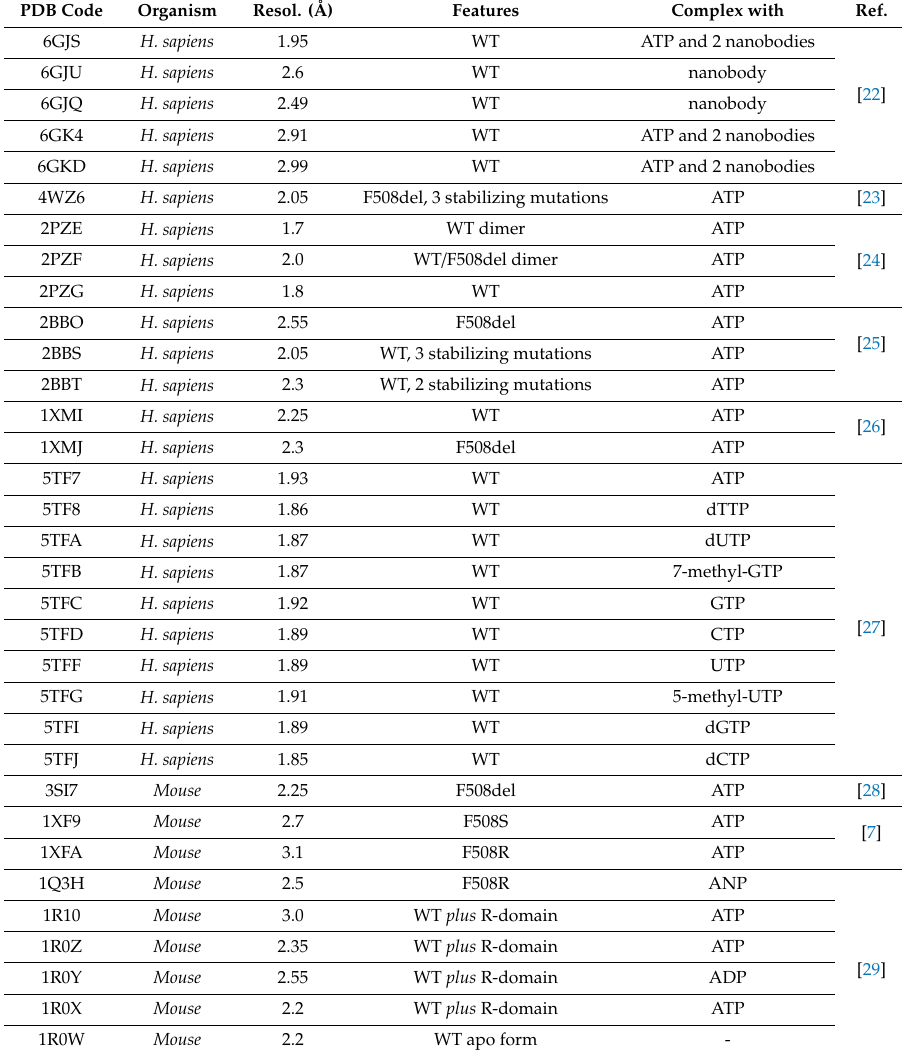
Figure 1. Schematic representation of the cystic fibrosis transmembrane conductance regulator (CFTR) structure. The different domains of the protein are indicated. Table 1. Structural data for human and mouse nucleotide-binding domain 1 (NBD1).